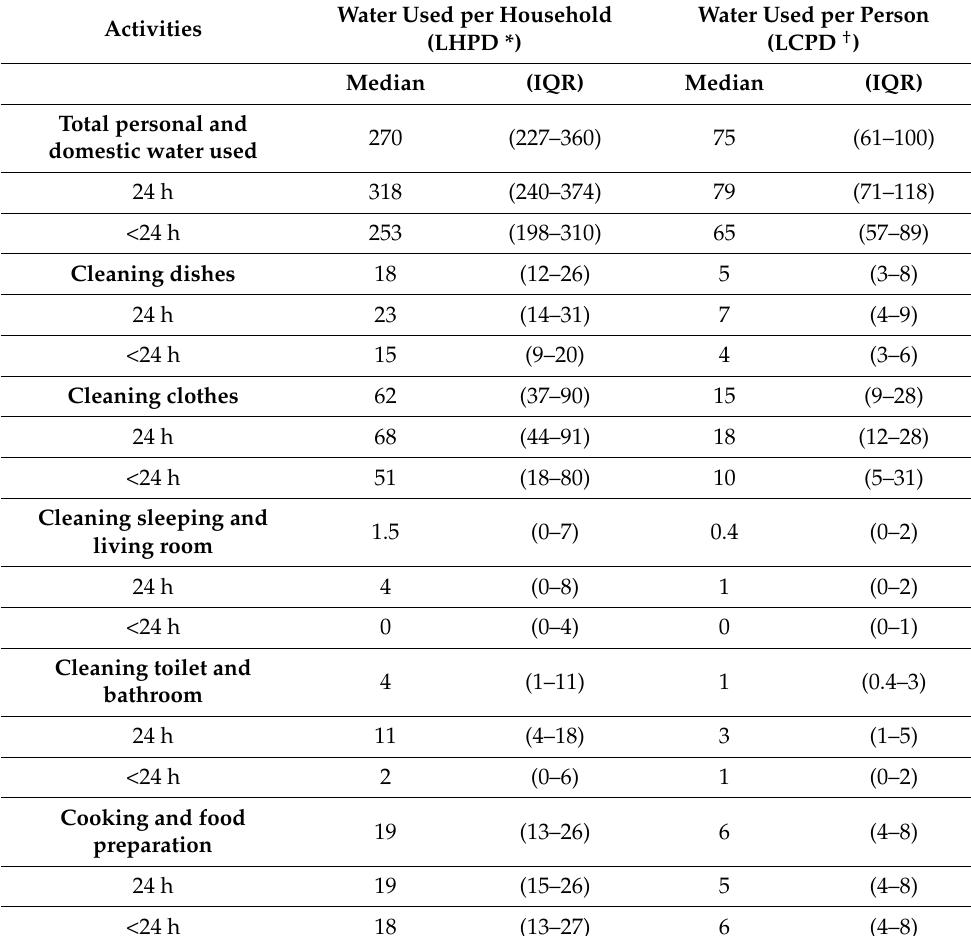
Table 3. Volume of water used based on water availability for domestic hygiene among the low- income urban community residents of Arichpur, Dhaka, from May 2015 to March